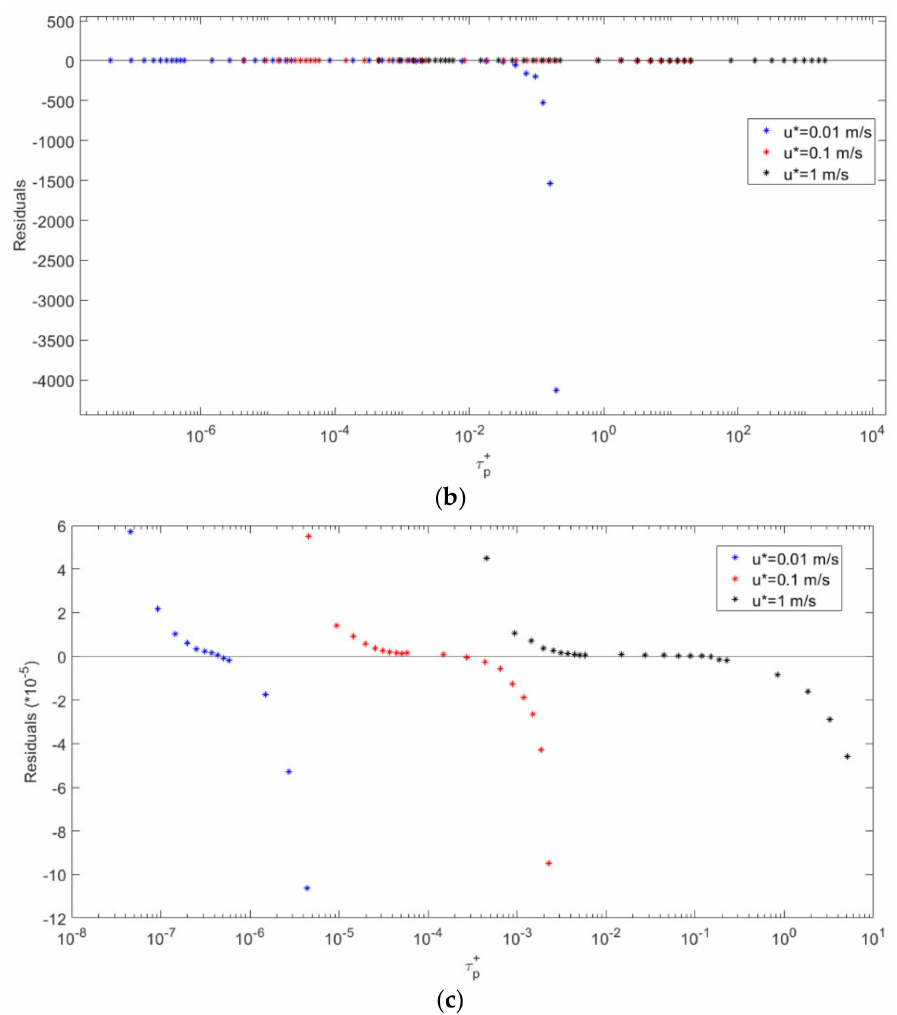
Figure 7. ( a ) A comparison, for gravitational settling and Fickian diffusion together, between the optimized code (dashed curves) and the unoptimized code (solid curves) for dry deposition velocity V + d . ( b – c ) the residuals between both